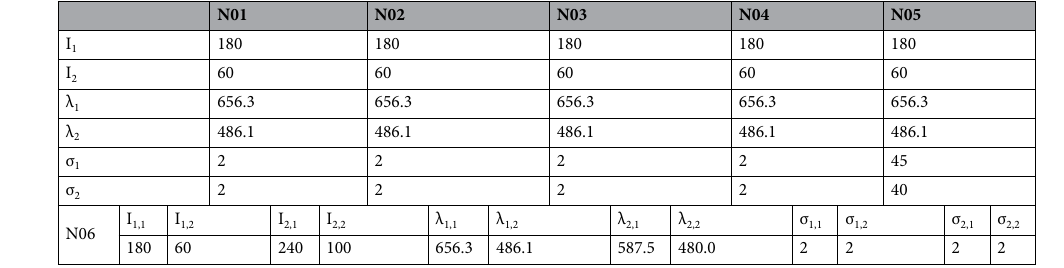
Table 2. Values used to generate the reference